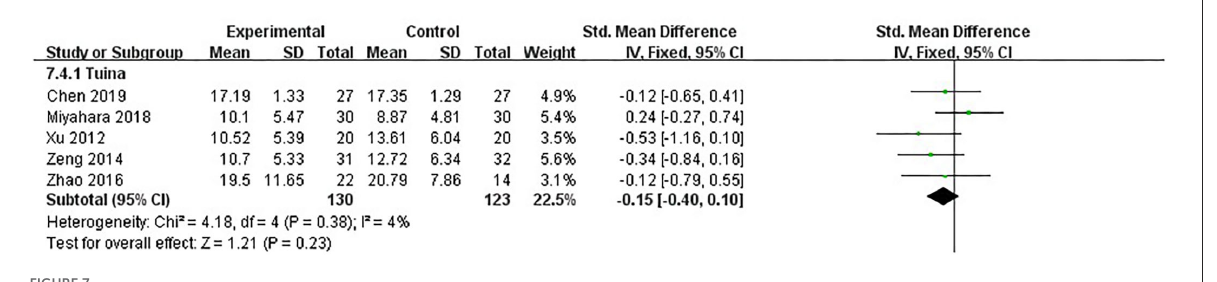
FIGURE7 Comparison 4: therapeutic massage vs. control. Outcome 4: